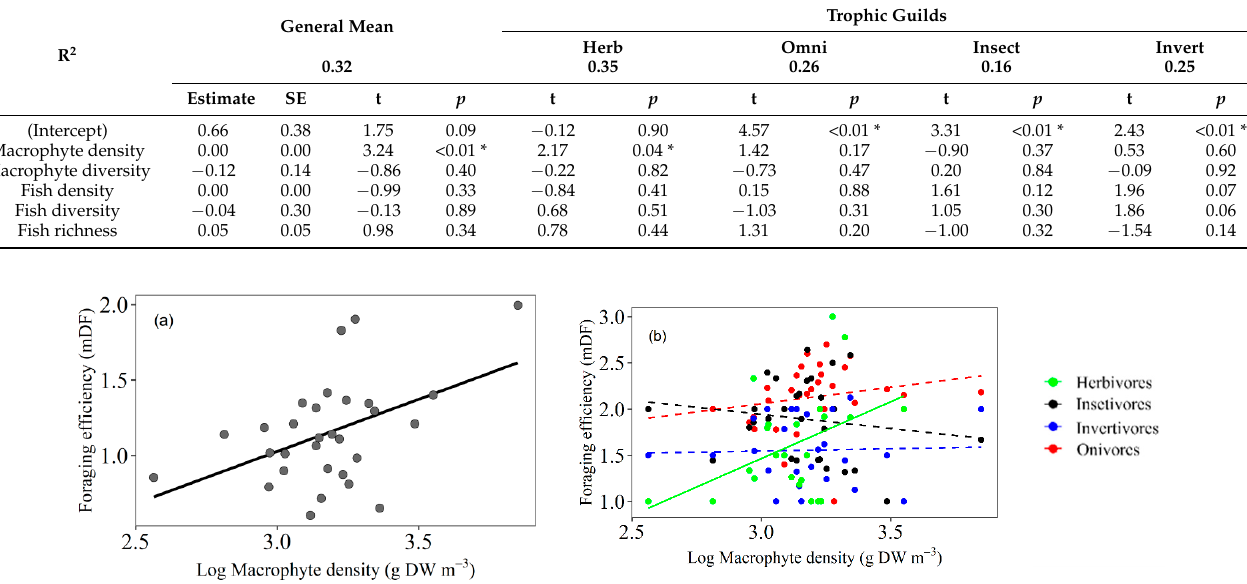
Figure 2. Fish foraging efficiency assessed by degree of stomach fullness, considering a general mean ( a —gray dots) and a mean calculated for each trophic guild separately ( b —colorful dots) related to the only variable with a significant effect in the generalized linear model performed for the general mean and for some of the trophic guilds. Dashed lines represent non-significant models. Note that log scale was used for macrophyte density.